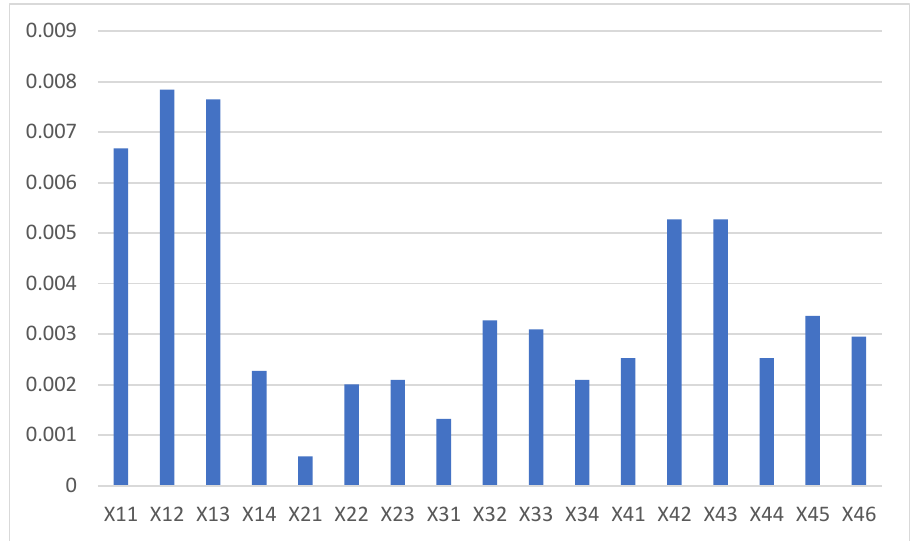
Figure 11. CR results of the influencing factors regarding laboratory safety levels.